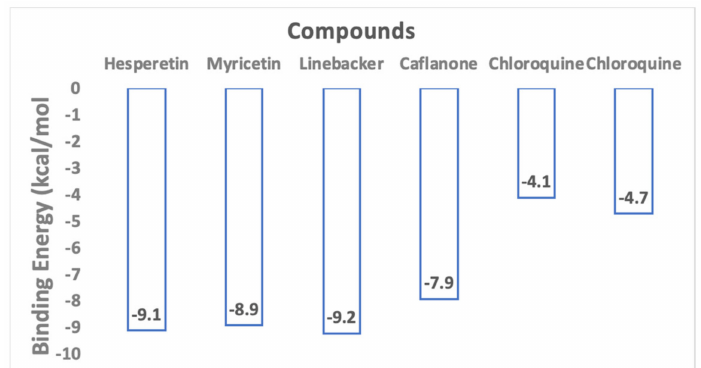
Figure 2. Docking study results show flavonoid molecules can bind very e ff ectively to the ACE2 receptor used by SARS-CoV-2 to infect cells. Two binding energies are shown for chloroquine due to two possible binding poses in di ff erent regions of the metallopeptidase domain.